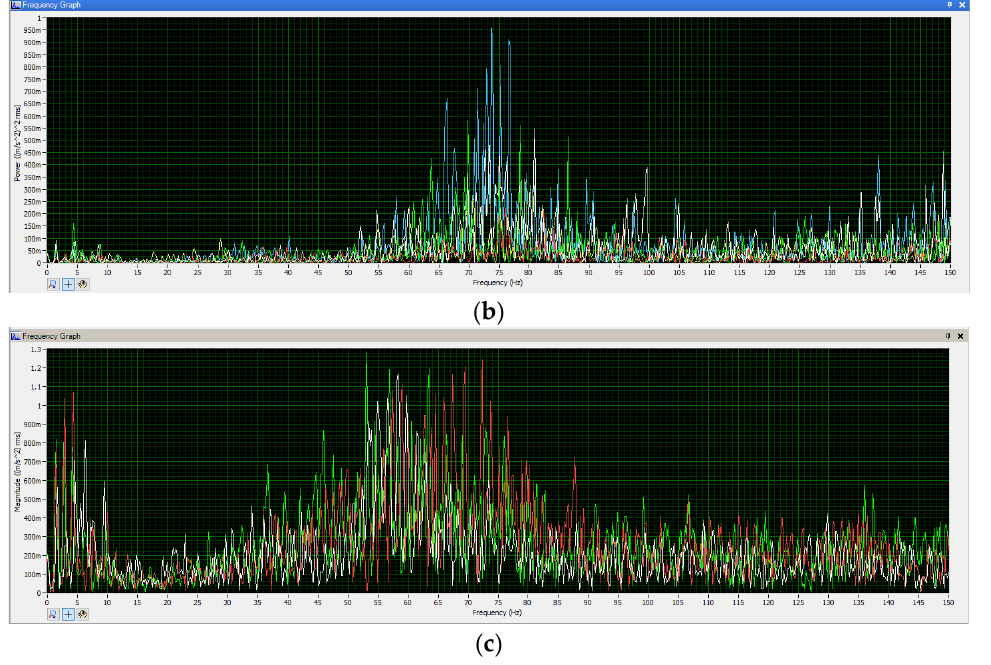
Figure 8. Distribution of frequency: ( a ) on x axis-longitudinal, ( b ) on y axis – transversal, ( c ) on z axis – vertical.